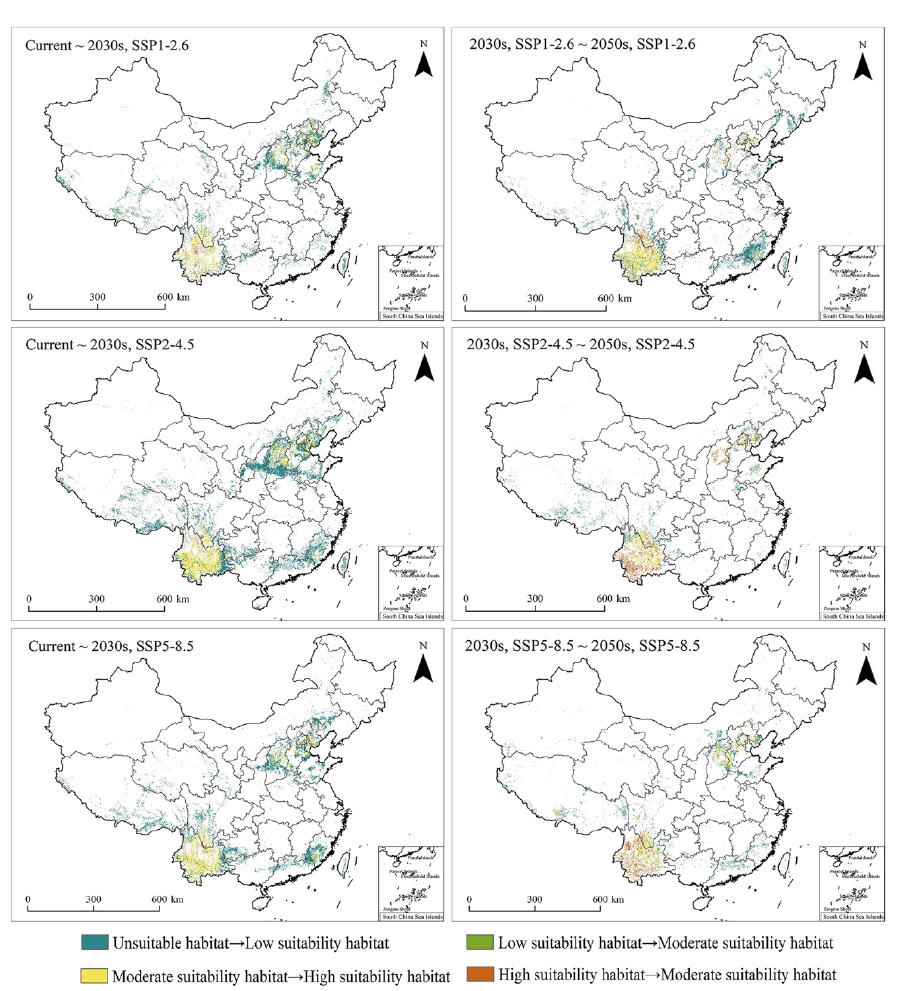
Figure 7. Changes in PGDs (Potential Geographical Distributions) of Tagetes minuta under different climate change pathways (SSP1-2.6; SSP2-4.5; SSP5-8.5) from the present to the 2030s and from the 2030s to the 2050s in China.